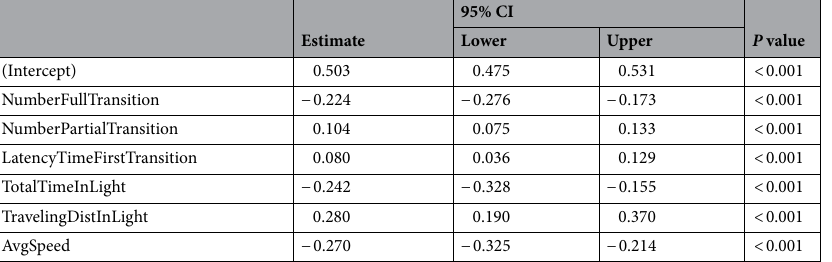
model (Table 1, Supplementary Figure S2). We then deployed this multivariate anxiety risk scoring model on the anxiety-like phenotypes measured in our current study to measure the effect of THS exposure on anxiety risk scores (see Supplementary Table S1 for all anxiety-related raw data and corresponding anxiety risk scores). Our results demonstrated that, based on the anxiety risk score (ARS) of the controls, CC042 and CC019 (ARS < 0.2),